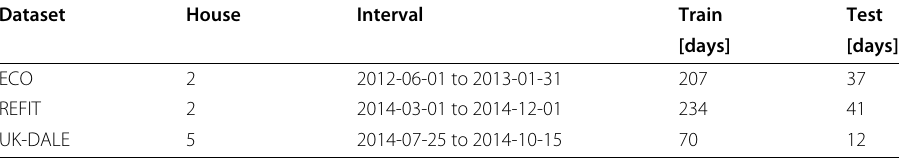
Table 2 Details on intervals and dataset